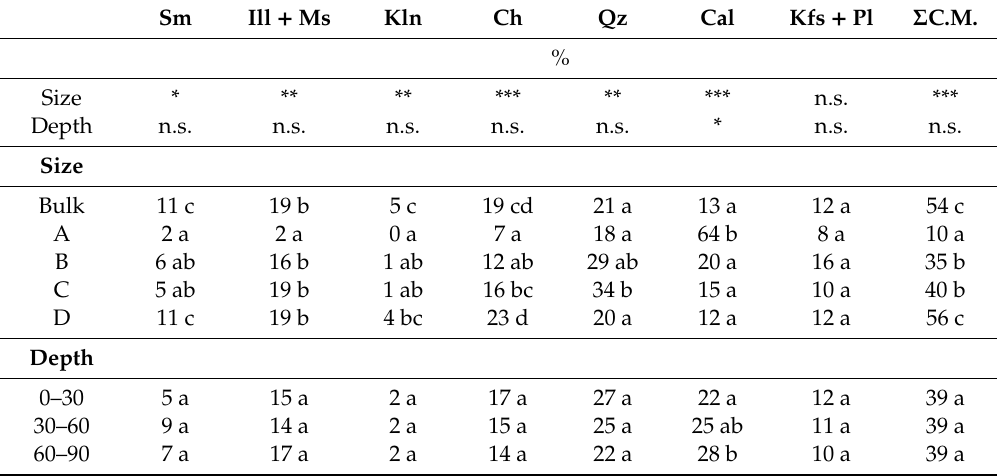
Table 2. Analysis of variance and mean values of the mineralogical composition subdivided by soil depth and size fractions under NT